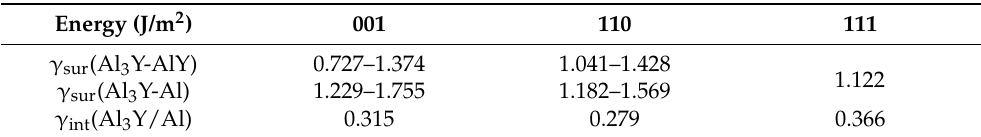
Table 5. Interfacial ( γ int ) energy obtained using Model 2 and calculated surface energies ( γ sur ) of Al and Al 3 Y.